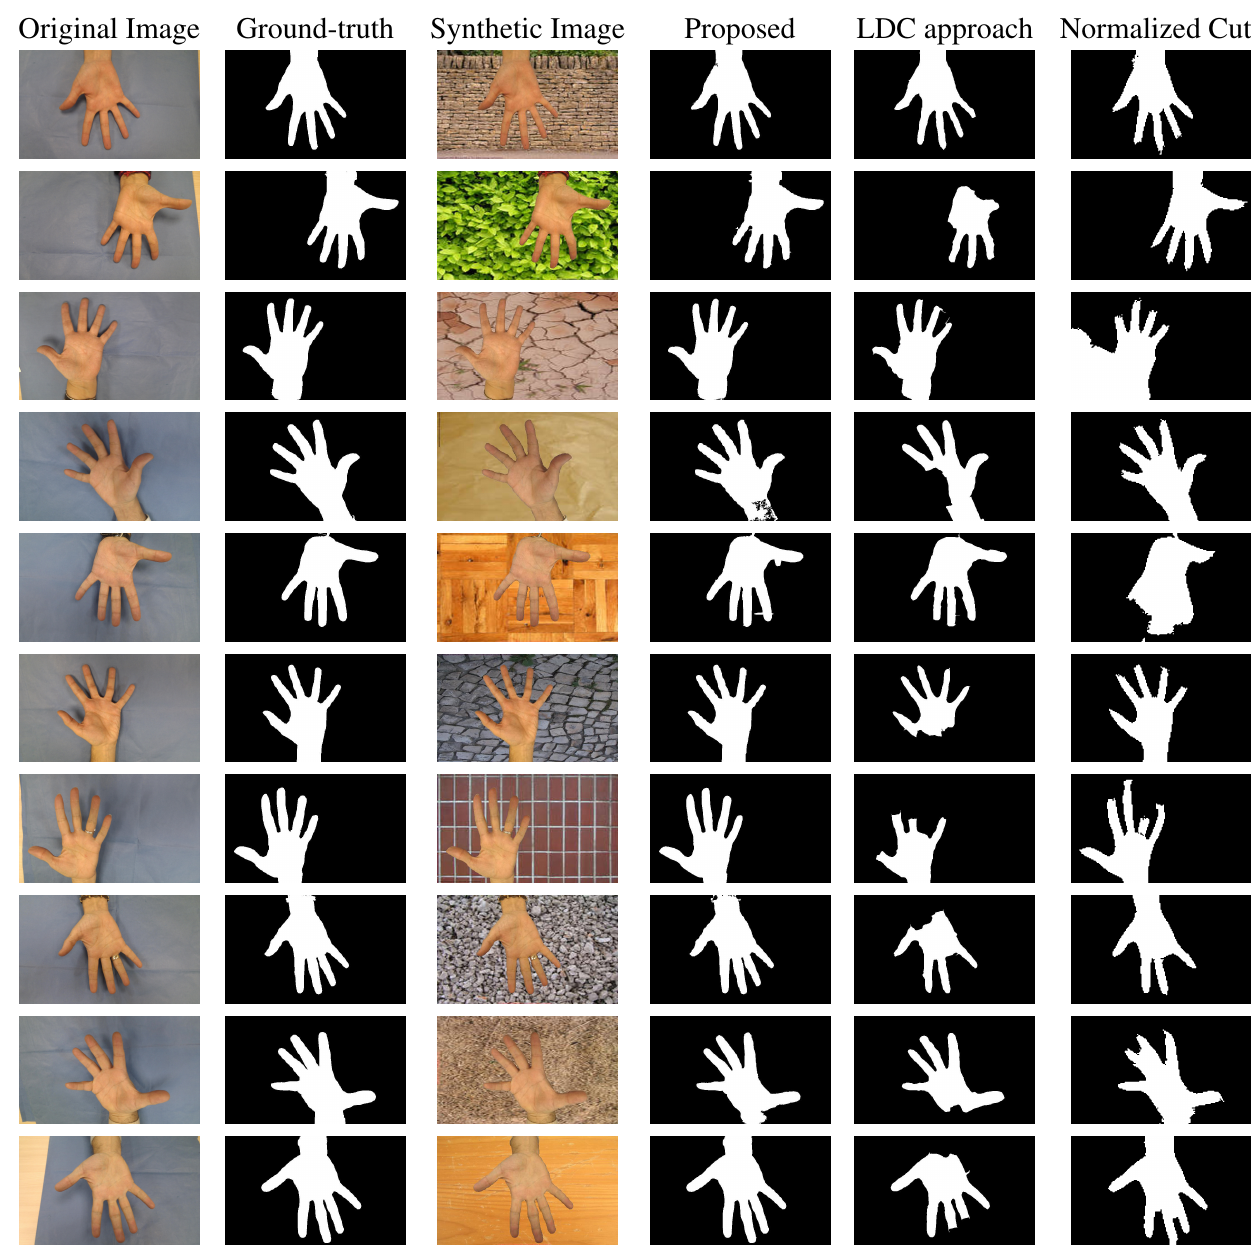
Figure 3. A comparative study of results provided by segmentation algorithm in comparison to ground-truth. First column gathers examples from first database, together with their segmentation on second column, considered as ground truth. Third column presents synthetic images based on first column images, providing on the fourth column the final segmentation result. Last two column present the segmentation result provided by the Lossy Data Compression (LDC) [7] and Normalized Cuts [8],